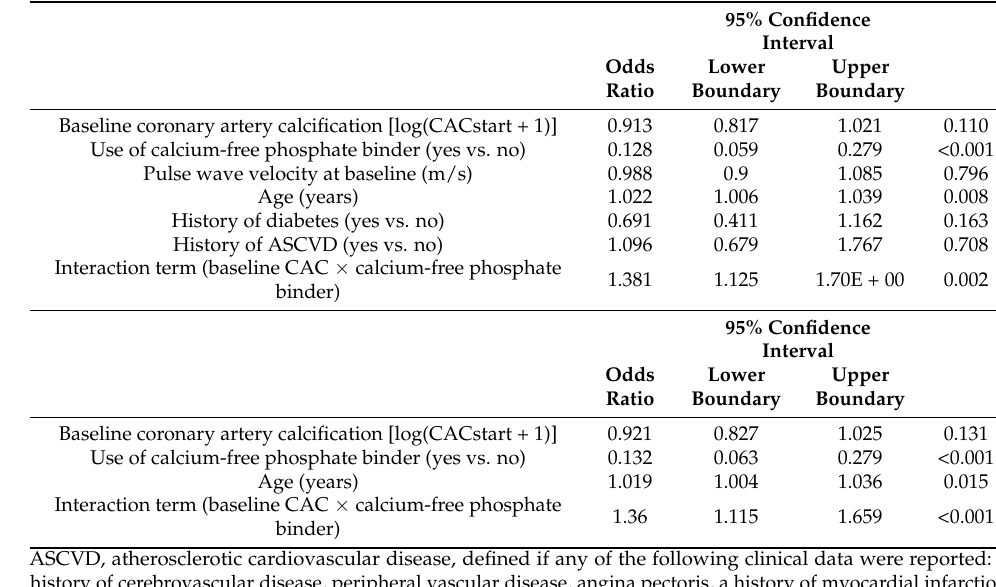
Table 2. Predictors of coronary artery calcification (CAC) progression by logistic regression analysis. (A) Fully adjusted model; (B) most parsimonious model selected according to a stepwise approach.